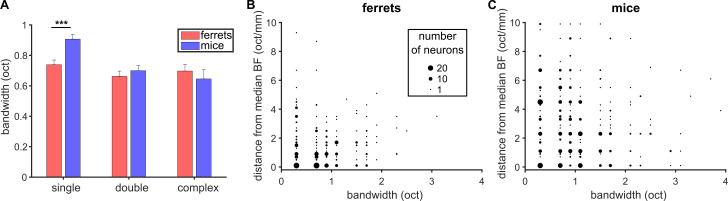
FRA bandwidth does not predict local tuning heterogeneity.(A) Average (mean ± SEM) frequency tuning bandwidth around BF for single-peaked, double-peaked and complex neurons in ferrets and mice (t-test; *** p < 0.001). (B, C) Scatterplots show the frequency tuning bandwidth as a function of the distance of the BF for each neuron from the median BF value in each imaging field in ferrets (B) and mice (C). Data are shown for single-peaked neurons only. Dot size is proportional to the number of neurons (see legend).